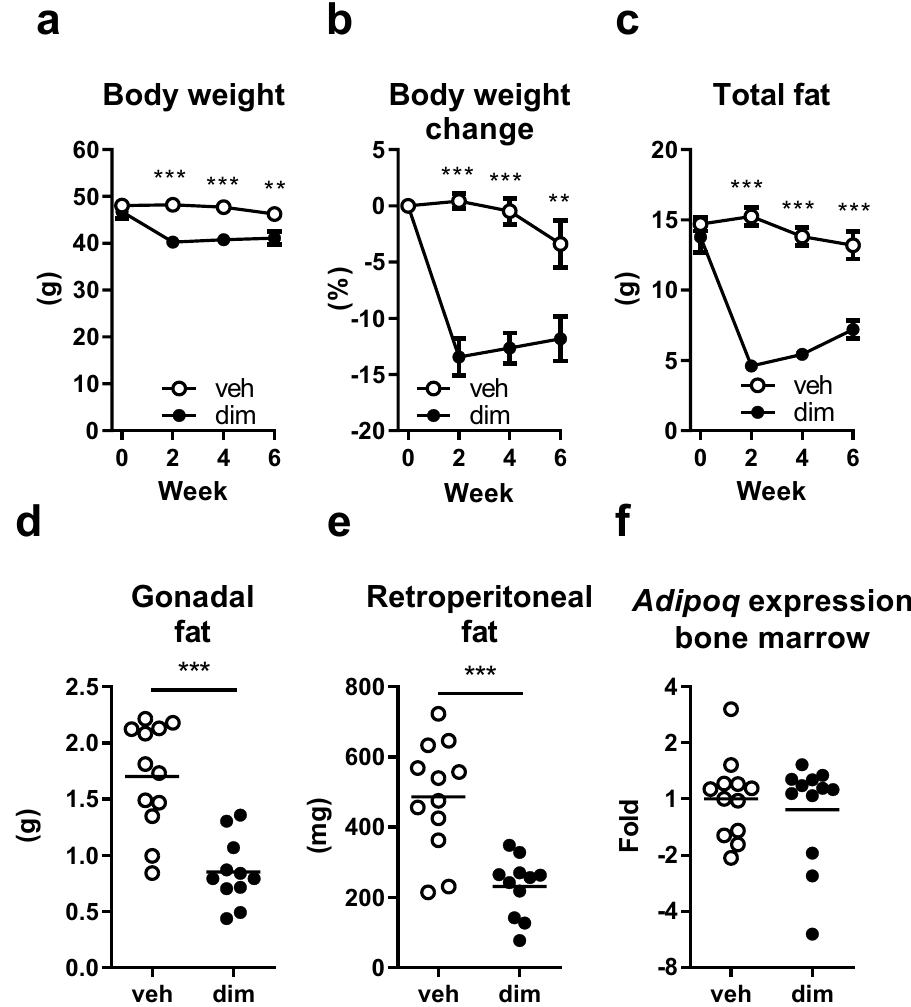
Figure 3. Adipocyte apoptosis resulted in long-term loss of peripheral adipose tissue. ( a ) Body weight, ( b ) percent body weight change, and ( c ) total fat mass, measured by DXA, at 0, 2, 4, and 6 weeks after dimerizer injection. Weight of dissected ( d ) gonadal and ( e ) retroperitoneal fat pads 6 weeks after dimerizer injection. ( f ) Tibial bone marrow adiposity, assessed by gene expression of the adiponectin gene ( Adipoq ) 6 weeks after dimerizer injection. ( a – c ) Data are arithmetic mean ± sem. ( d – e ) Symbols in the scatter plots represent individual mice and the bars indicate arithmetic mean. ( f ) Symbols in the scatter plot represent individual mice and the bars indicate geometric mean. dim, dimerizer; veh, vehicle. n = 12 veh and 12 dim mice. ( a – e ) Student’s t-test. *** P <